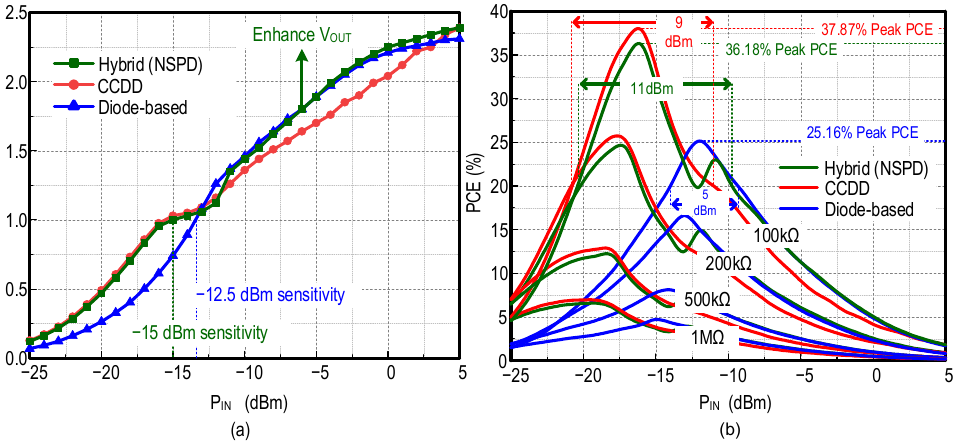
Figure 14. Postlayout simulation of ( a ) RFEH front-end output voltage across different input powers at 100 k Ω with impedance matching, ( b ) the power conversion efficiency across different input powers at various load conditions with impedance matching.